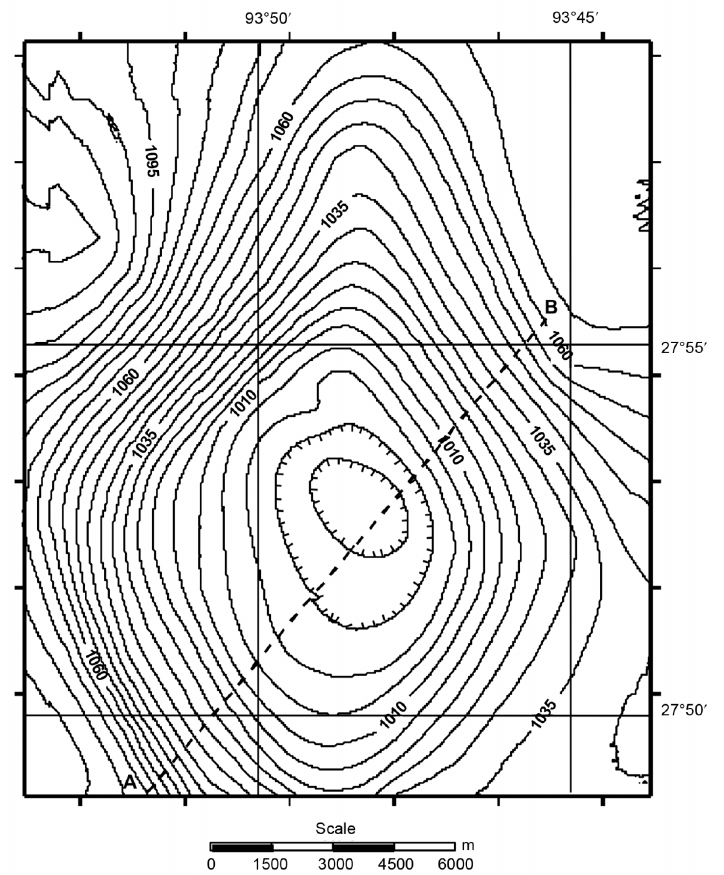
Fig. 5. Gravity map observed over inferred salt dome causing anomaly in water-bottom tomography in Gulf of Mexico (contour interval is 5 mGal) (modified form Dobrin and Savit,